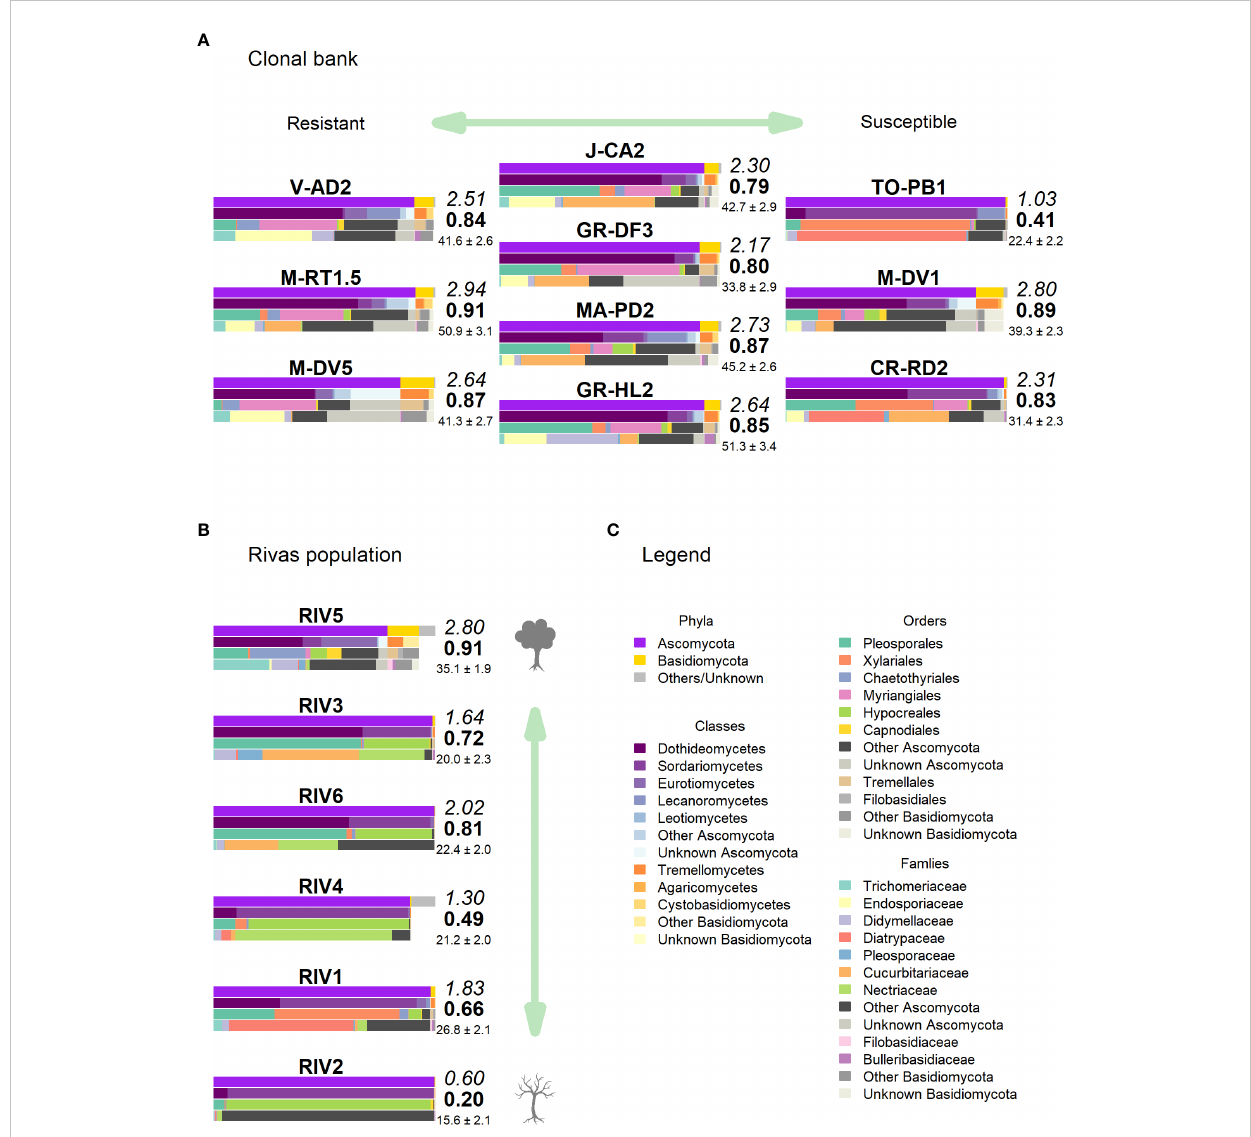
FIGURE 5 Taxonomic composition in (A) clonal bank and (B) Rivas population. Only the most relevant taxa are shown. Colored bars represent the frequency of taxa at the levels of phylum, class, order and family (top to bottom), following legend color code (C) . Numbers next to the bars indicate the Shannon (italics) and Simpson (bold) indices and the OTU richness rarefacted to 500 reads (with standard error). (Tree icon sources: minimal tree simple SVG Silh, licensed under CC0 1.0 and tree-304418 by Clker-Free-Vector-Images in pixabay under Pixabay